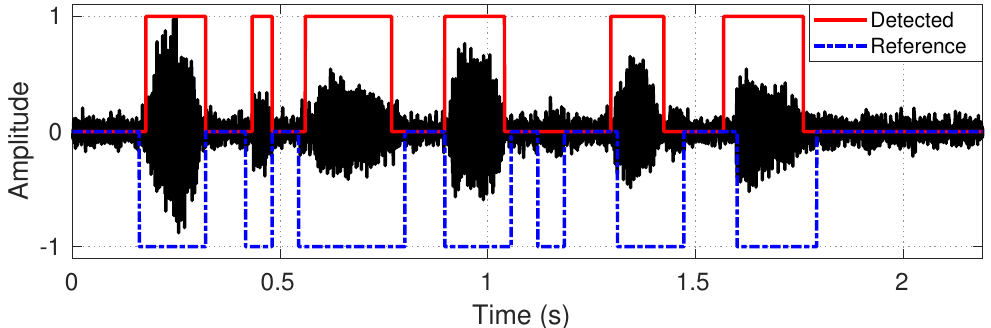
Figure 5. Comparing the detected flags of Figure 2b to that of the reference corresponding to Figure